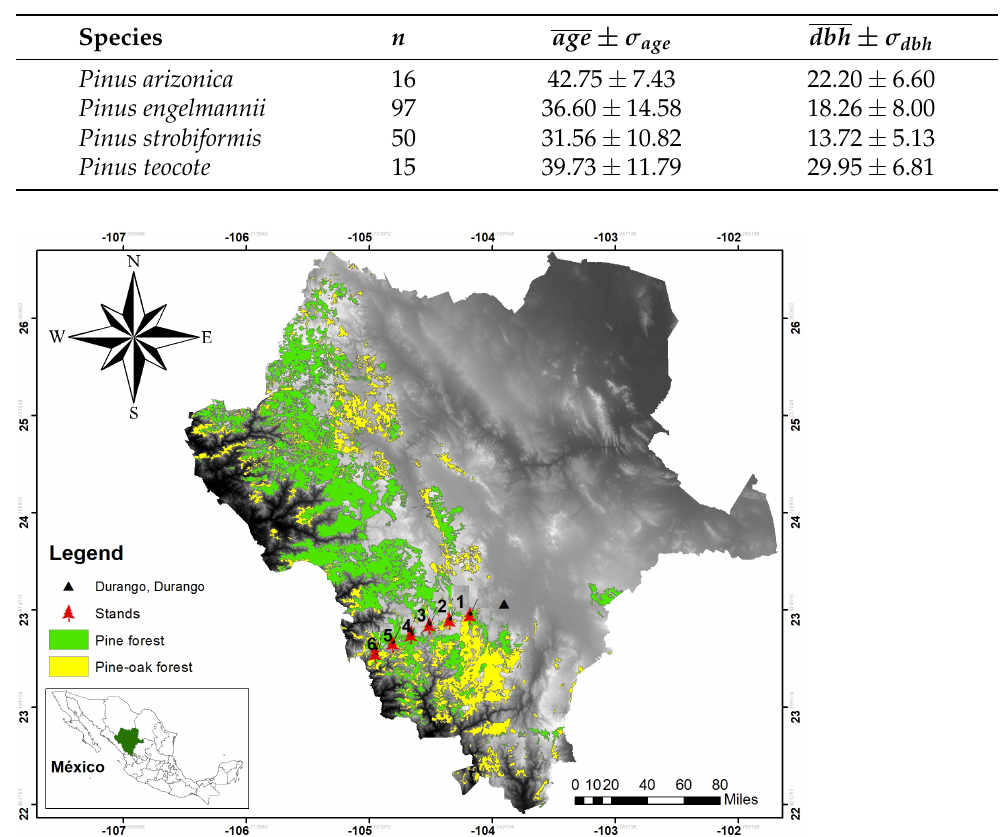
Figure 1. Study site including the six 50 × 50 m plots, each separated by a distance of 17,000 m in the transect (taken from